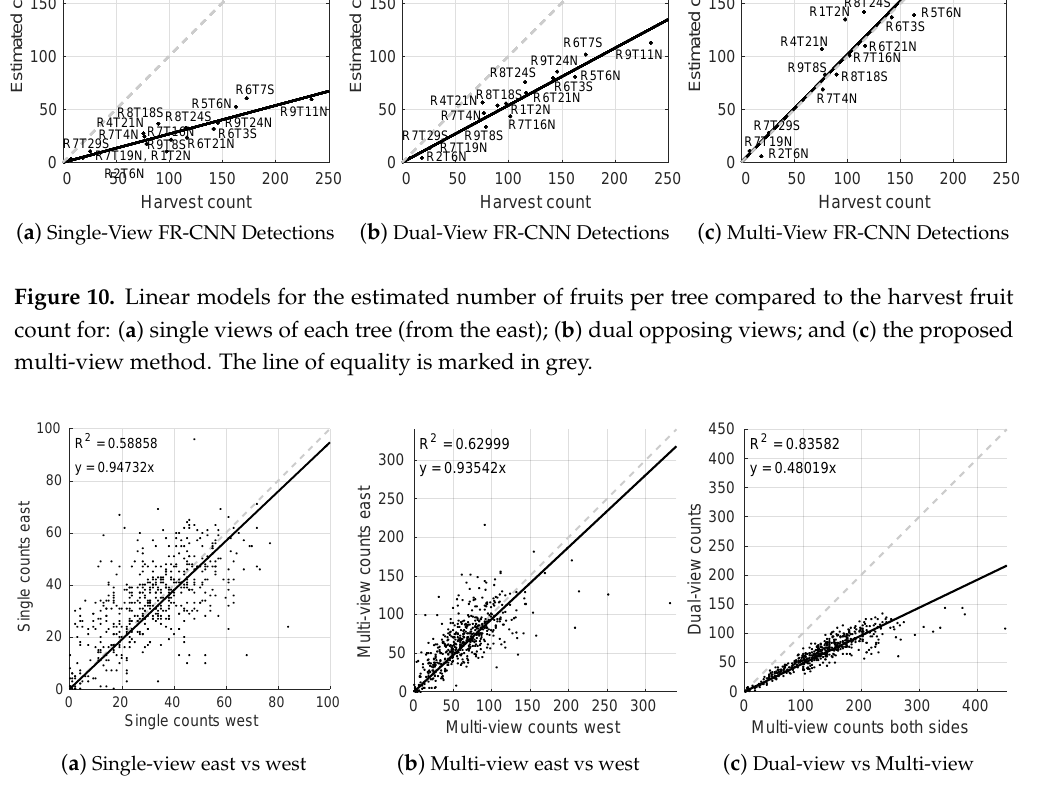
Figure 11. The relationship of fruit counts from opposing sides of every tree using ( a ) single-view and ( b ) multi-view approaches. The relationship between dual-view and multi-view estimates is shown in ( c